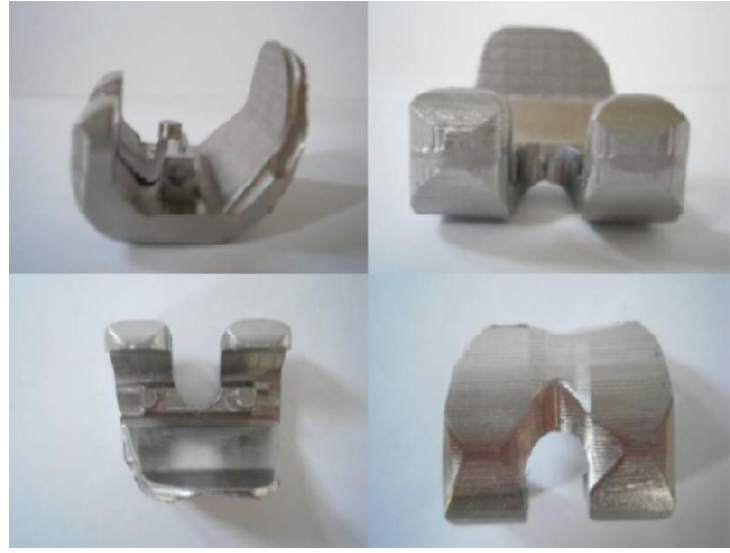
Figure 8. Views of the implant after the second machining stage. Table 2. Machining parameters values for each zone and each component. Zones of the Component